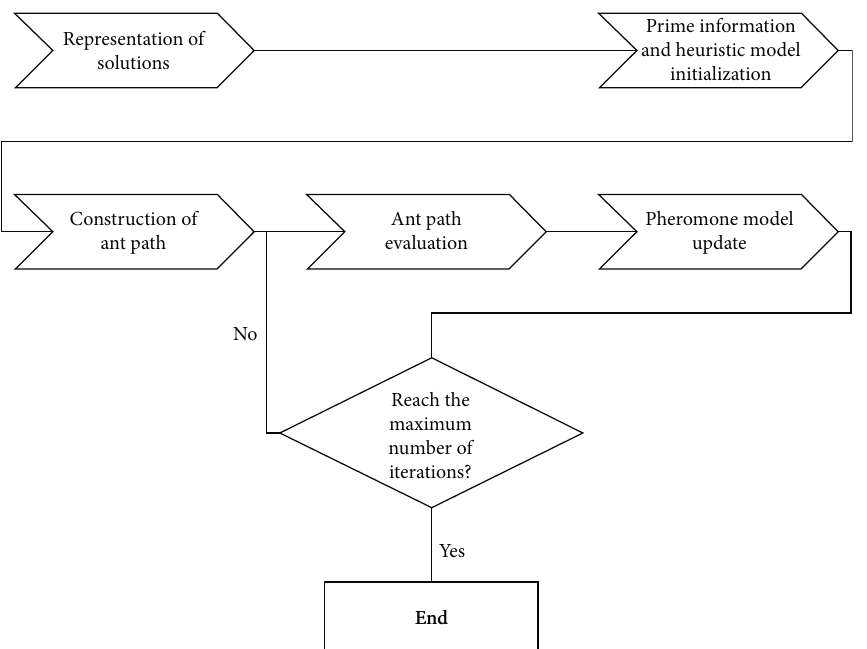
Figure 3: Ant colony optimization algorithm framework.